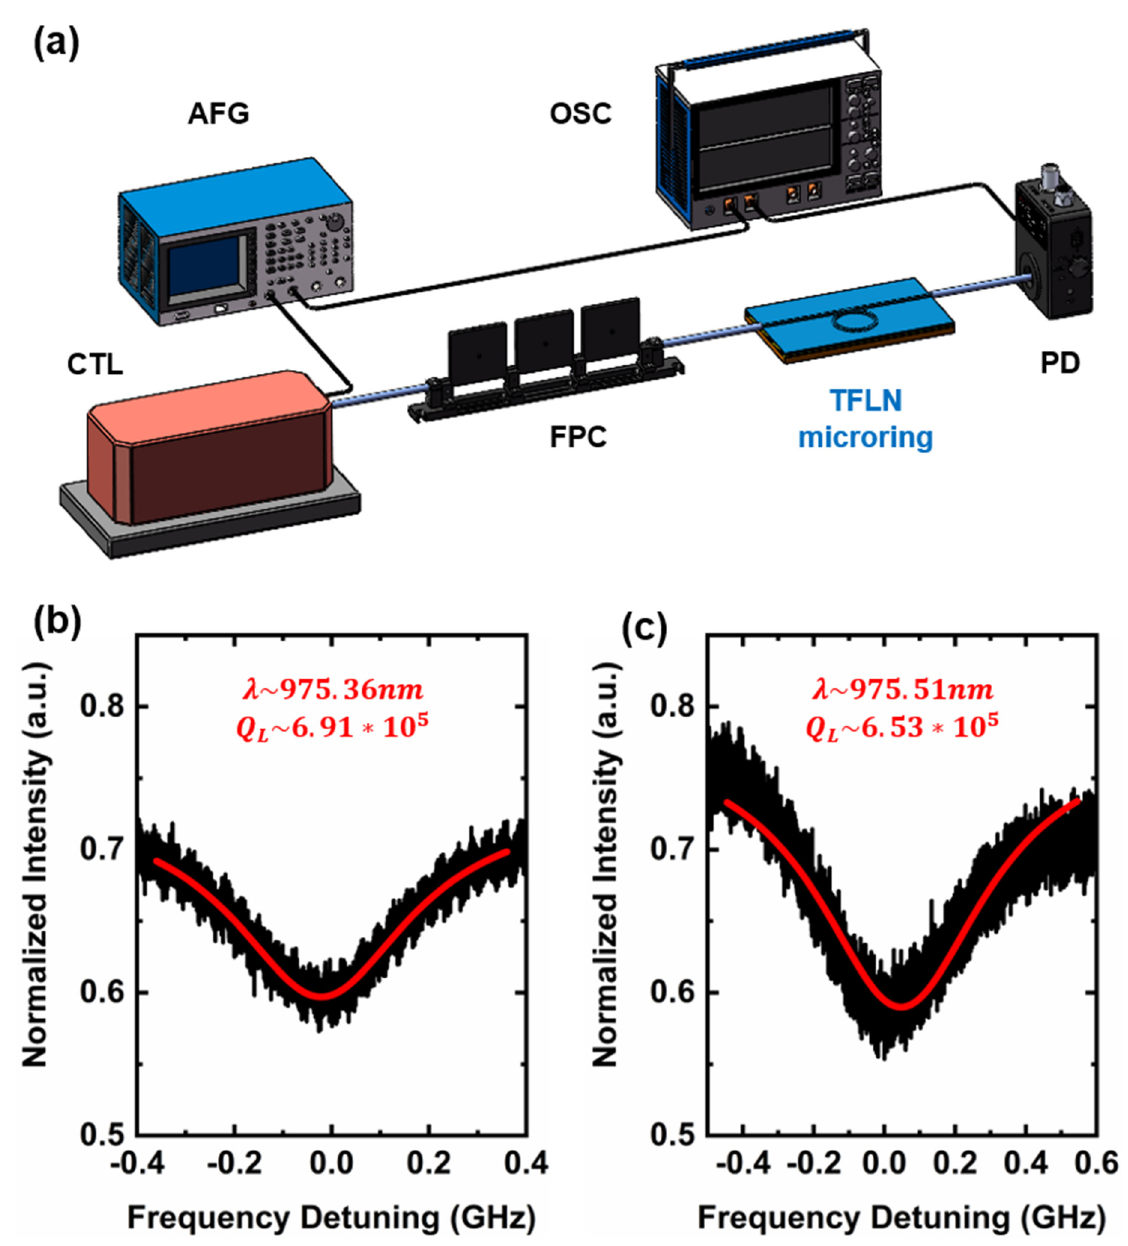
Figure 3. ( a ) Schematic diagram of the experimental apparatus for the characterization of the loaded Q factor of the LN microring resonator (CTL: continuously tunable laser; AFG: arbitrary function generator; FPC: fiber polarization controller; PD: photodetector; OSC: oscilloscope). ( b , c ) The two adjacent transmission spectra of the LN microring laser at 975 nm of the pumped laser. The Lorentz fitting (red curve) reveals a Q-factor of 6.91 × 10 5 at the wavelength of 975.36 nm, while the Lorentz fitting (red curve) reveals a Q-factor of 6.53 × 10 5 at the wavelength of 975.51 nm.